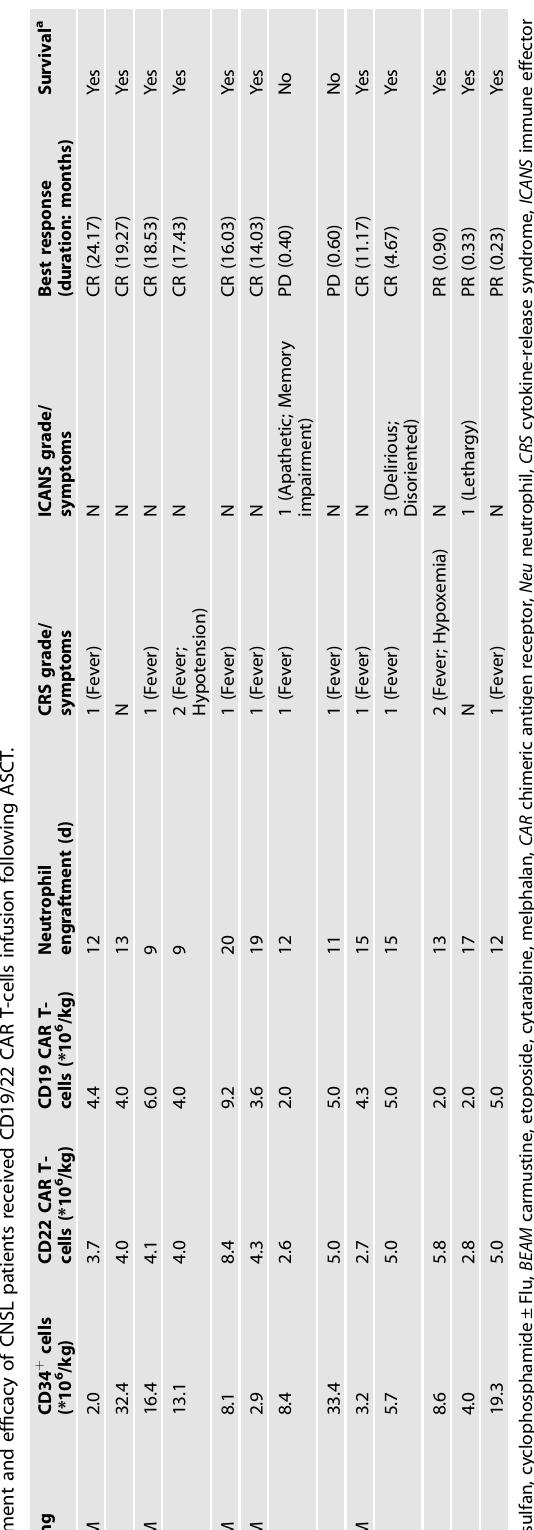
and complete remission rate (CRR) were 81.81% and 54.55%, respectively. Patient 11 developed disease progression after achieving PR status in the fi rst ef fi cacy assessment. The median durable time for the nine responsive patients was 14.03 months (range: 0.23 – 19.27 months); 18.18% (2/11) of patients (cases 7 and 8) did not respond to the current treatment protocol and maintained progressive disease (PD) status (Fig. 2A). MRI images for three representative patients before therapy and at the time of best response are shown in Fig. 2B. As of March 15, 2021, the median follow-up time of all enrolled patients was 14.20 months (range: 1.37 – 24.17 months), and only two systemic NHL patients with CNS involvement/relapse (cases 7 and 8) refused further treatment due to multiple virus infection and/or rapid disease progression. Both died shortly after leaving hospital, with a median survival time of 2.33 months (range: 1.5 – 3.17 months). The median PFS and OS after ASCT and CAR T- cell infusion were unde fi ned, and the estimated 1-year PFS and OS rates were 74.59% (95% CI: 39.76 – 91.10%) and 82.50% (95% CI: 46.10 – 95.33%), respectively (Fig. 2C). Side effects After CAR T-cell infusion, 11 (84.62%) patients (except cases 2 and 12) had low-grade CRS. Nine had fever over 38 °C and were assessed as having grade 1 CRS, and two exhibited grade 2 CRS and presented with fever and hypotension or hypoxemia; no patient suffered grades 3 – 4 CRS. In addition, case 7 presented with apathetic and mild memory impairment (ICE score: 8 points) and case 12 with lethargy (ICE score: 9 points) both were assessed as grade 1 ICANS. Patient 10, who appeared delirious and disoriented (ICE score: 1 point), was diagnosed with grade 3 ICANS. The cumulative incidence of ICANS was 27.27%. Grade 1 CRS cases were reversed after timely administration of broad-spectrum antibiotics, while patients with ICANS or grade 2 CRS were recovered by simultaneously combing with intravenous methyl- prednisolone injection, no patient had residual neurological impairment. Other side effects included viremia (4/13) and upper respiratory infection (1/13); one (case 7) patient refused further therapy because of multiple virus infection (CMV, JCV, BKV, TTV) and disease progression, and others were supported by effective anti-infection treatment. As shown in Fig. 3A, the developed ferritin index varied, increasing from the baseline level except for cases 9 and 13, as did the IL-6 level, excluding cases 1 and 12. Ferritin and IL-6 reached the peak levels (ferritin: 2235 µg/L; IL-6: 194 pg/mL) on the median 8th and 7th day after the fi rst CAR T-cell infusion, respectively. In addition, increases in serum ferritin and IL-6 levels were often accompanied by CRS and ICANS, and patients who experienced grade 2 CRS or grade 3 ICANS had peak serum ferritin and IL-6 levels greater than 3000 µg/L and 300 pg/mL, respectively. CAR T-cell kinetics Except for patient 10, the remaining 12 patients underwent ddPCR testing for absolute quanti fi cation of CAR gene expression to better understand the expansion of CAR T-cells in vivo. As shown in Fig. 3B, the median peak numbers of CD19 and CD22 CAR T- cells lentivirus copies in vivo were 911 (range: 33 – 6900) and 3346 (range: 57 – 42188) copies/µg DNA, respectively, and achieved peak levels with median times of 1.36 (range: 0.72 – 1.86) and 1.46 (range: 0.43 – 3.00) weeks after CAR T-cell infusion, respectively. Interestingly, the lentivirus copies of CD19 and CD22 CAR T-cells in all patients except patient 8 (who suffered early death without explicit data) were unabiding, only with median durable times of 8.43 (1.29 – 20.72) and 8.57 (2.00 – 45.43) weeks, respectively. The CAR T-cells percentage in CD3 + cells was measured by fl ow cytometry; only case 2 received regular detection monthly for the fi rst 3 months after CAR T-cells infusion, followed by evaluations at ~6 and 12 months, and the peak percentages of CAR T-cells in CD3 + cells in the CSF and PB were 46.38% and 17.58%, respectively. T a